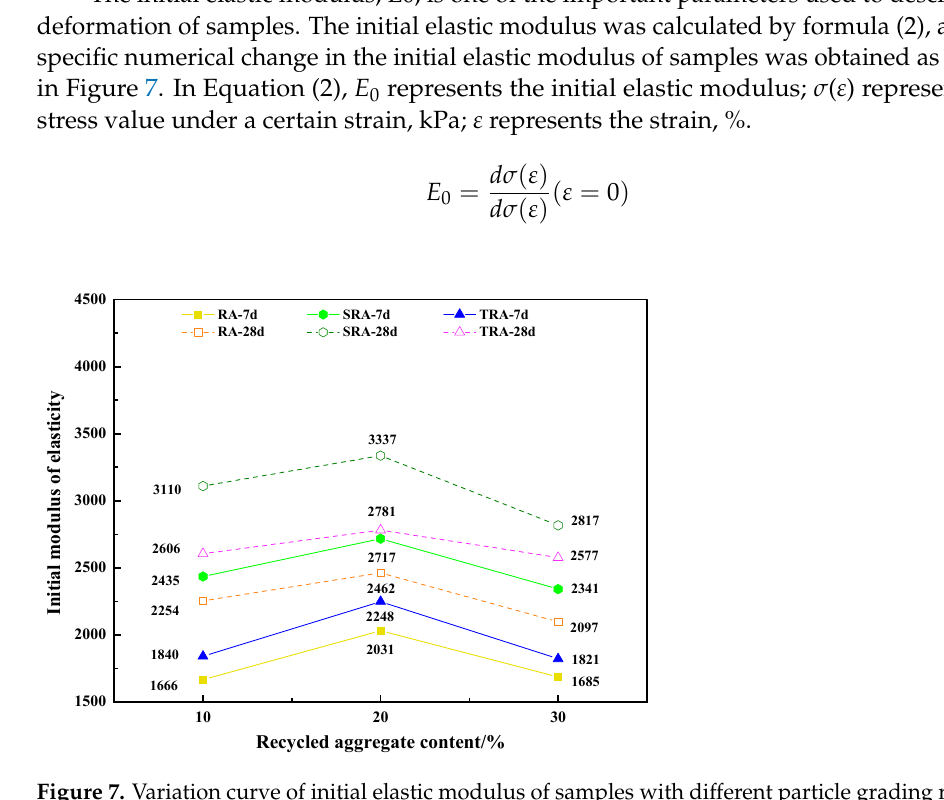
Figure 7. Variation curve of initial elastic modulus of samples with different particle grading recycled aggregate contents.